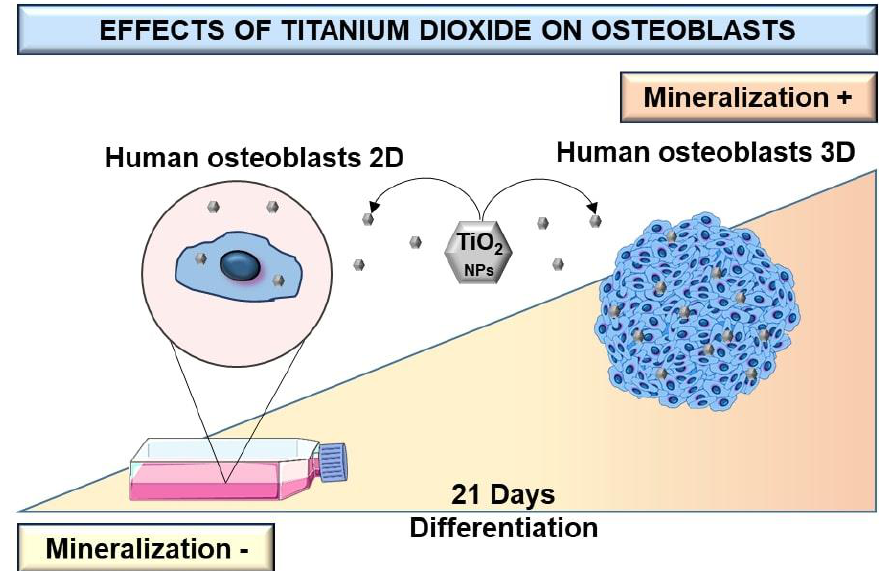
Figure 7. Scheme of differentiation and production of a mineralized matrix of human osteoblasts SAOS-2 cultured in monolayer and 3D spheroid cell models after exposition to TiO 2 . After high TiO 2 NPs exposure, the dose-dependent increase of bone-mineralized matrix in the 3D cells model is higher than in monolayer (2D) culture.